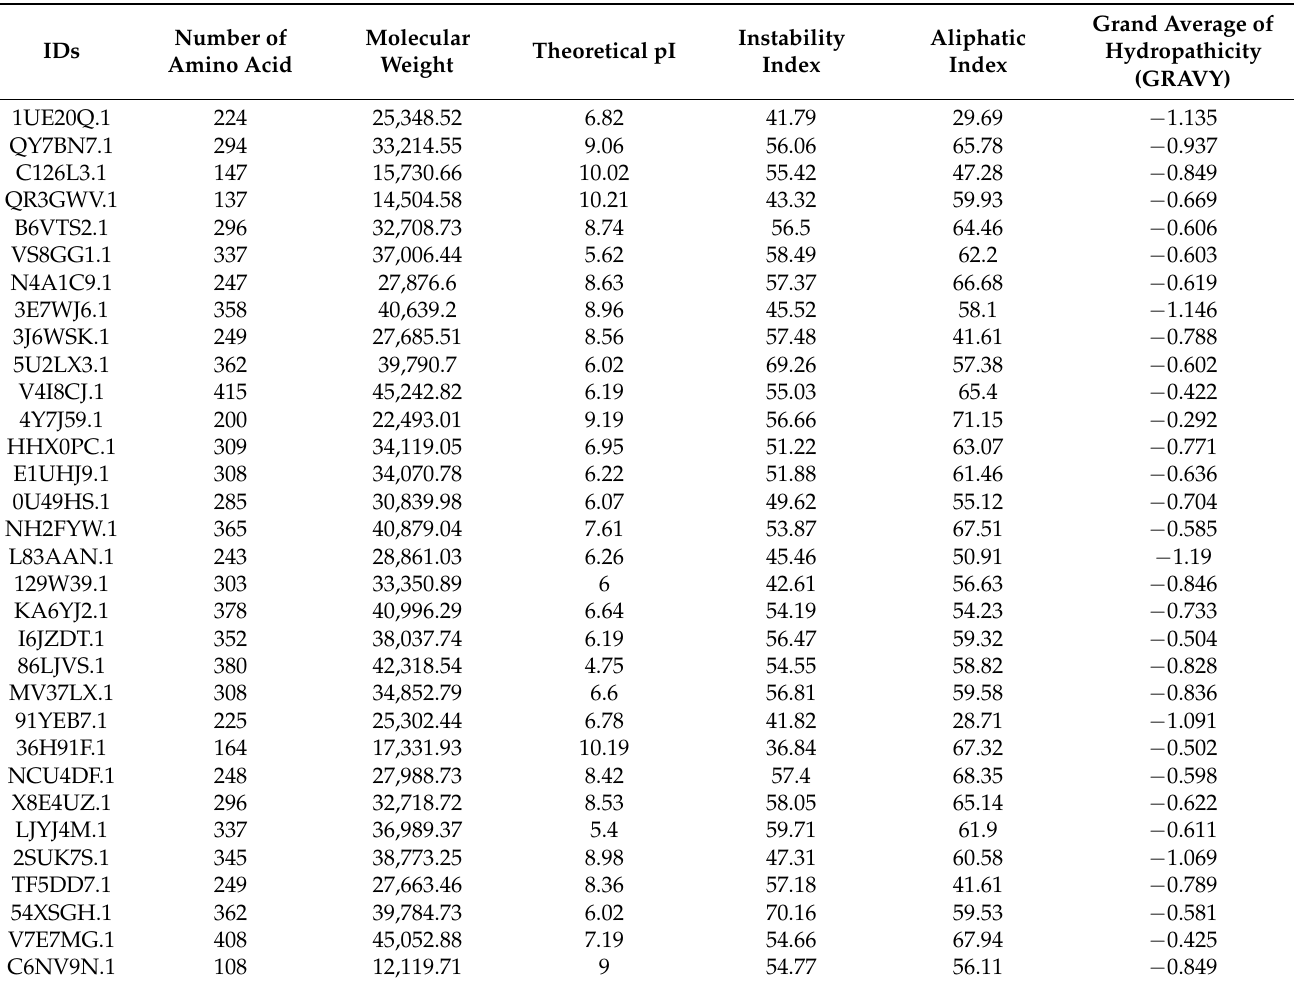
Table 1. Characteristics of 45 GATA gene family members in the Arachis hypogaea L.